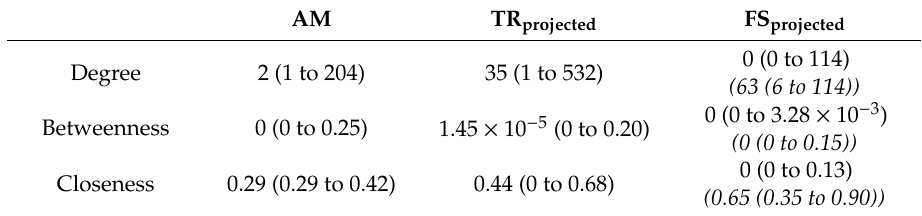
Table 3. Median (range) centrality parameters of the animal movements network (AM), the projected transportation network (TR projected ), and the projected feed supply network (FS projected ). For the projected feed supply network, the italic numbers in parentheses illustrate the values calculated without isolated